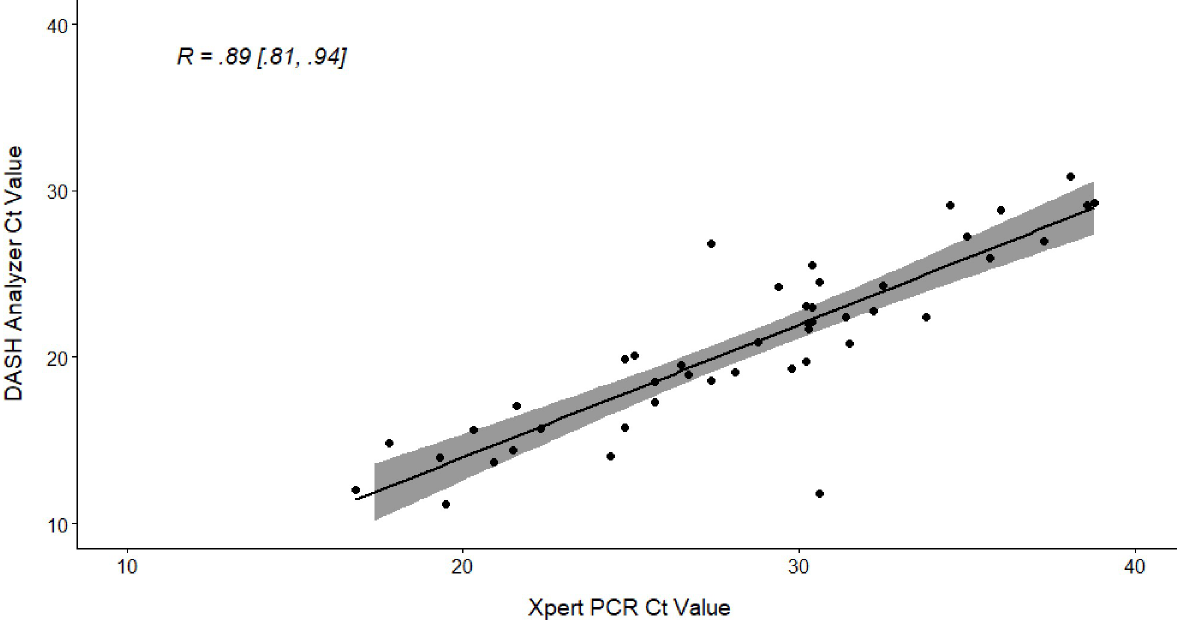
Fig 3. Correlation analyses for comparison of Diagnostic Analyzer for Selective Hybridization (DASH) PCR and Cepheid Xpert Xpress PCR cycle threshold (Ct) values.